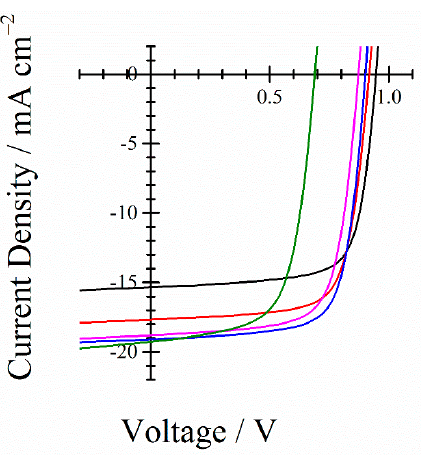
Figure 4. J – V characteristics of PBDB-T/IT-M/Y6 ternary blend polymer solar cells with different compositions: 1 : 1 : 0 (black line), 1 : 0.9 : 0.1 (red line), 1 : 0.8 : 0.2 (blue line), 1 : 0.7 : 0.3 (purple line), and 1 : 0 : 1 (green